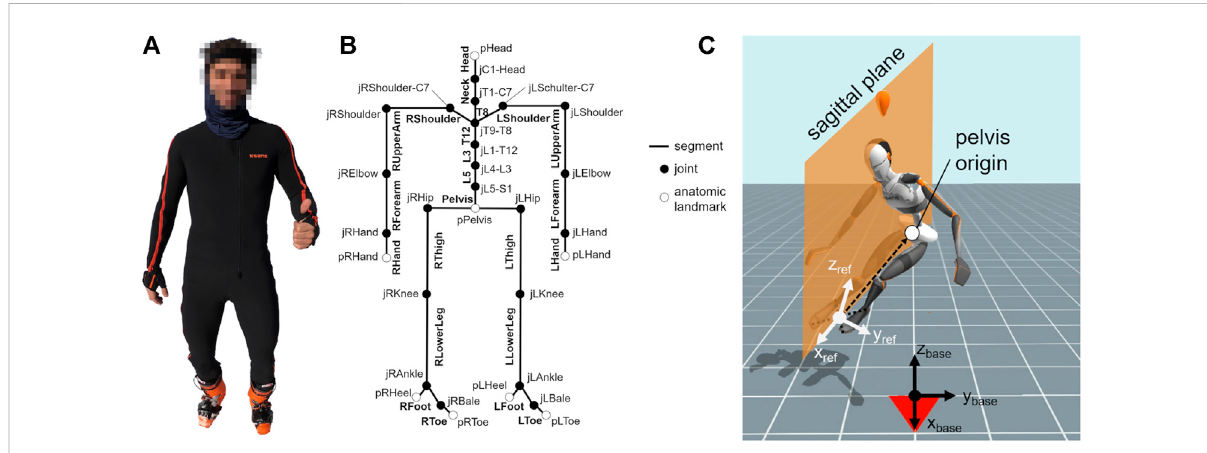
FIGURE 2 (A) Volunteer wearing the Xsens ™ suit for skiing: sensors on the feet were attached to the ski boots from the outside; (B) body model with extractedreferencepointsforbodysegmentpositions; (C) reconstructedavatar(adoptedfromXsens ™ software)withreferencecoordinatesystem.